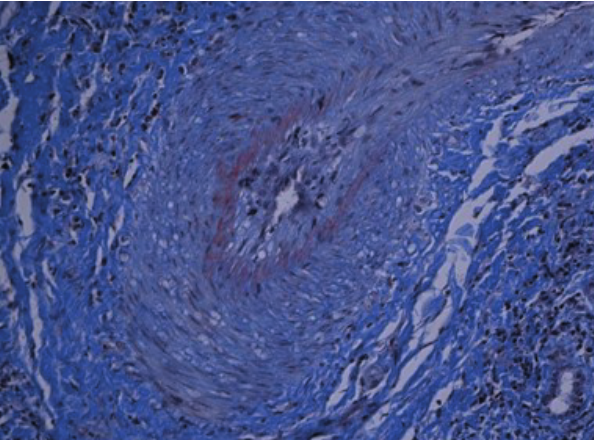
Figure 3. MSB stain. X200 magnification. Showing fibrin deposits and arterial inflammation.